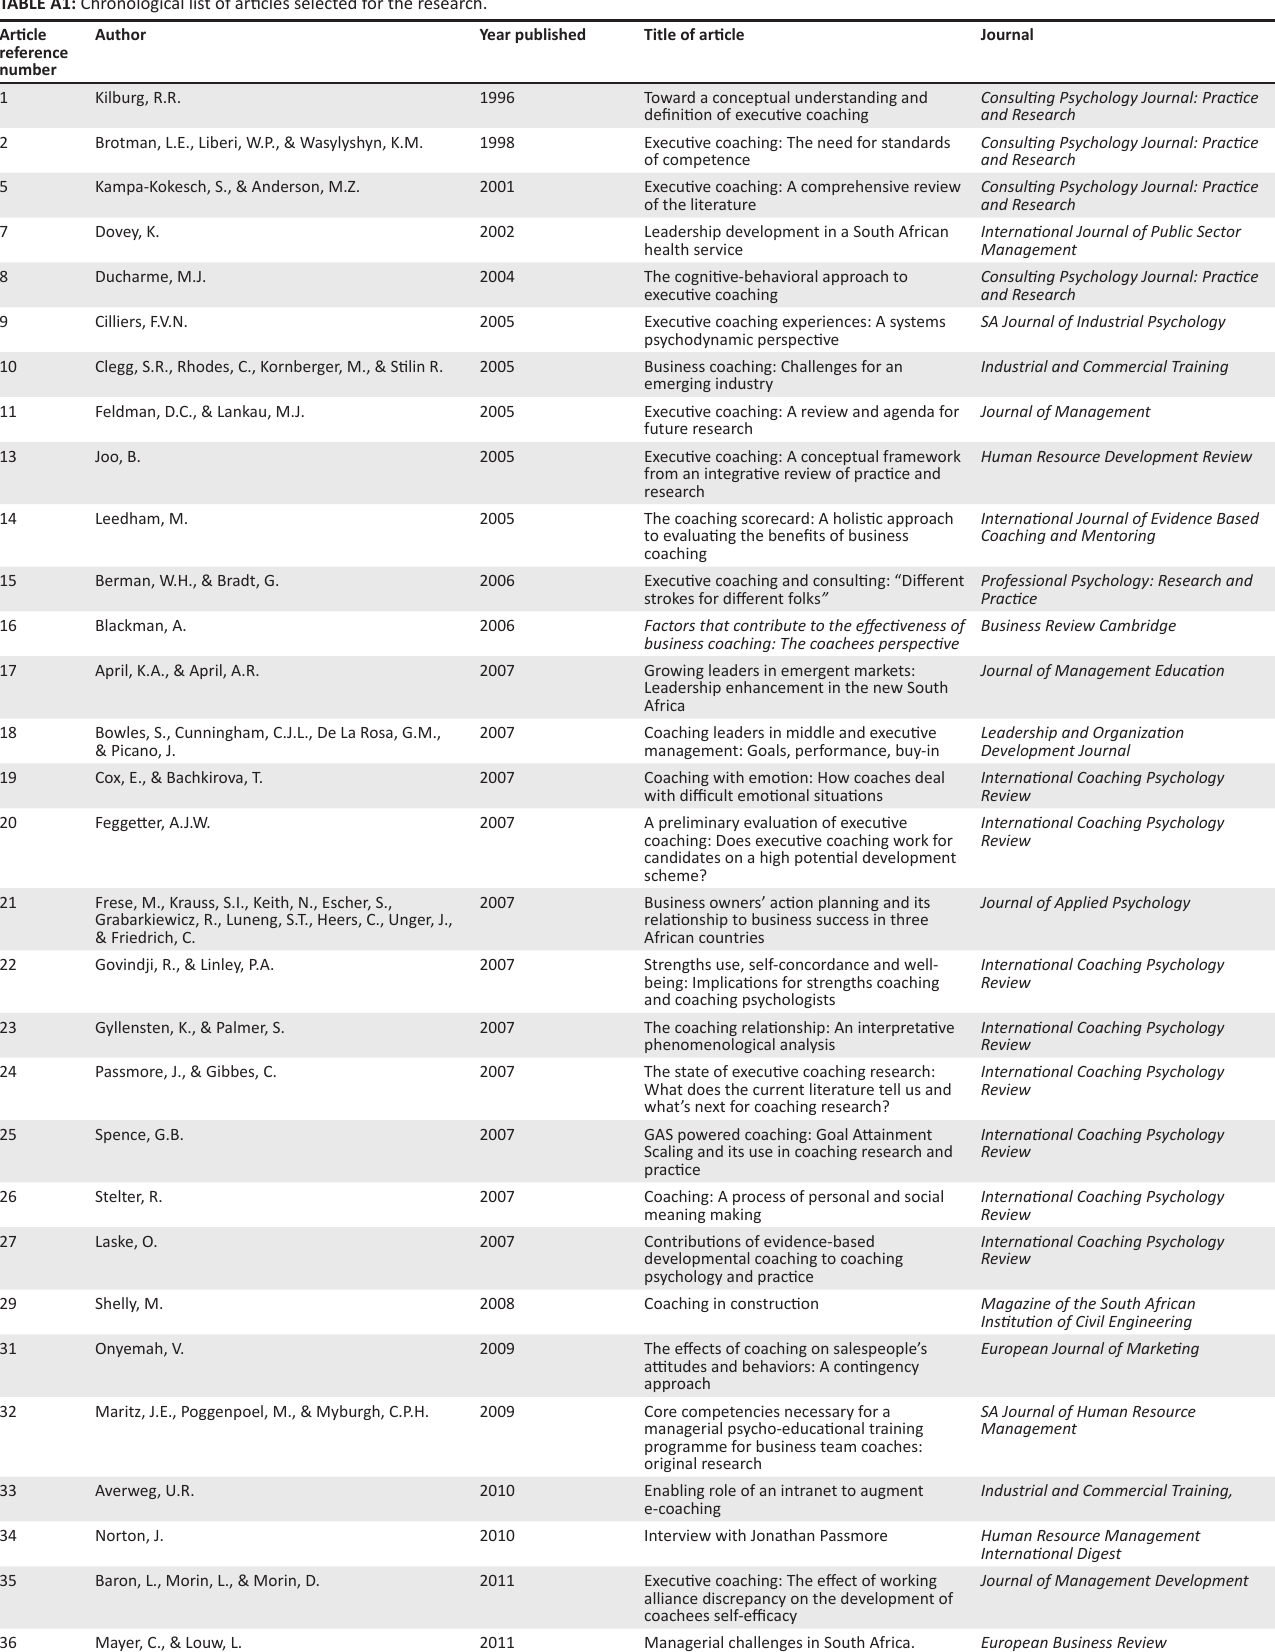
TABLE A1: Chronological list of articles selected for the